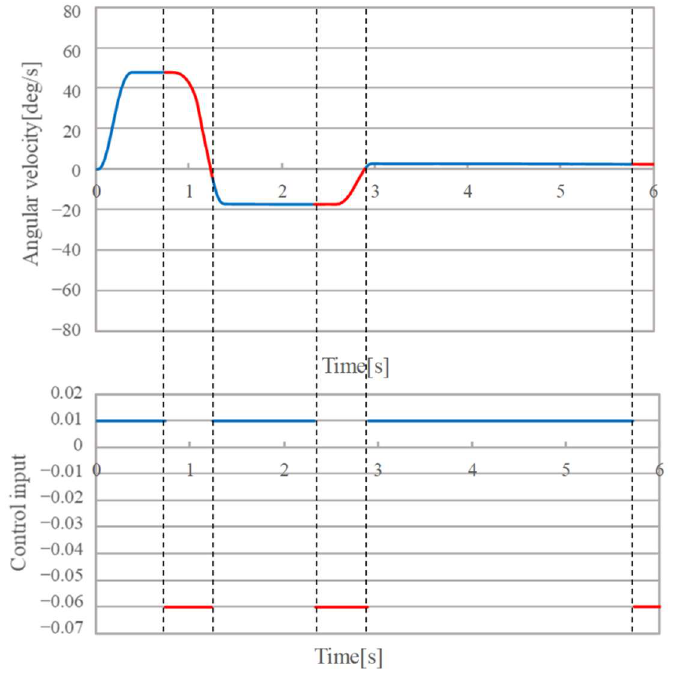
Figure 15. Time history of angular velocity and control input (numerical results).